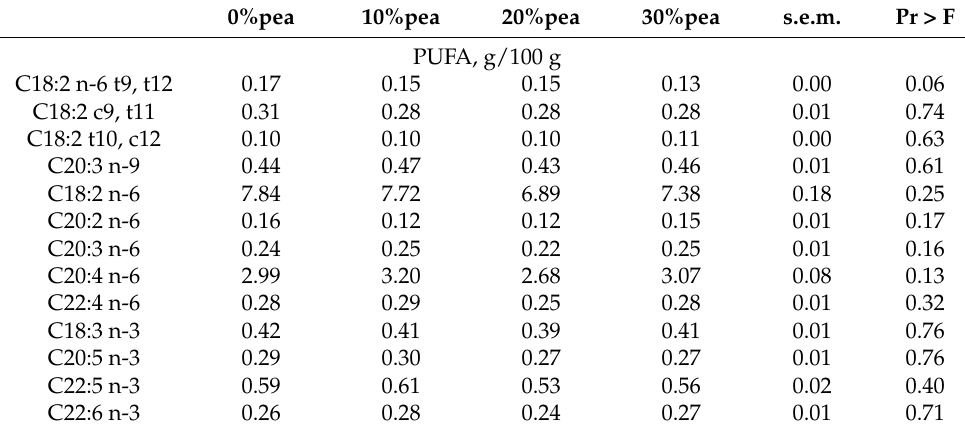
Table 5. Effect of the proportion of pea in the individual polyunsaturated fatty acids (PUFA) in LTL muscle. 0%pea